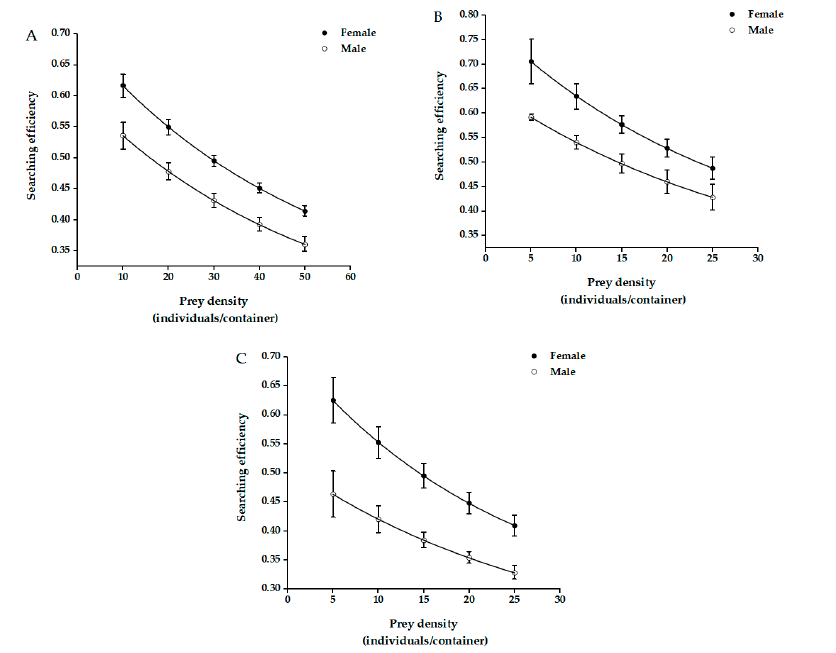
Figure 2. Searching efficiency of C. elysii adults for juvenile ( A ), immature ( B ), and adult ( C ) A. agrestis individuals